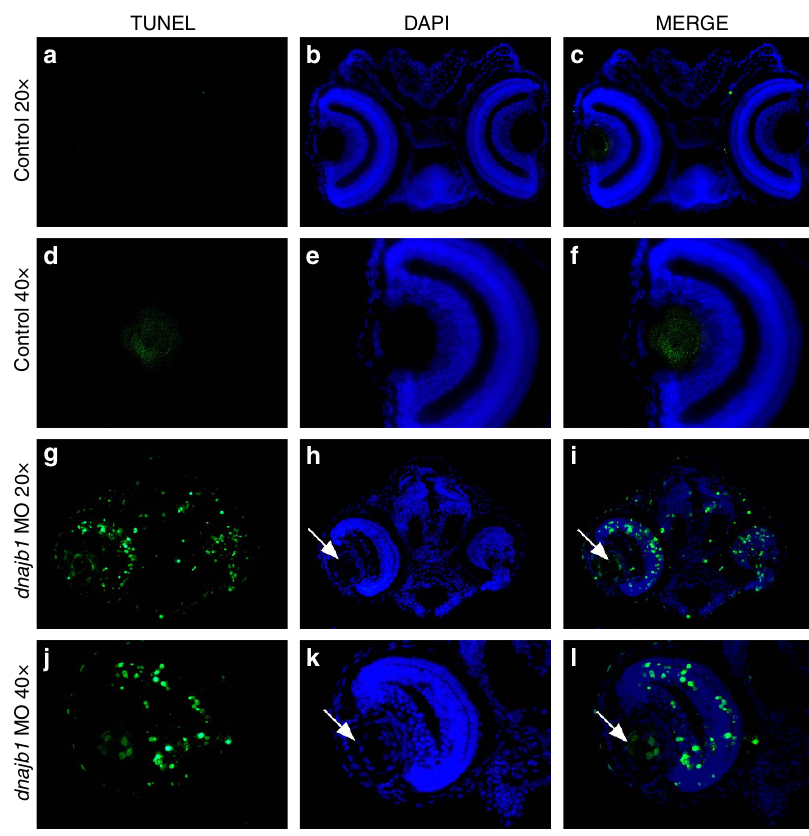
Figure 6 | dnajb1 morphants display significant apoptosis in the eye. TUNEL staining of control embryo sections ( a – f ) and dnajb1 morphants ( g – l ) injected with the dnajb1a sbMO (5ng). The dnajb1a morphants show significantly increased apoptotic nuclei throughout the eye compared with the control embryo, which was completely devoid of TUNEL-positive nuclei. The morphant lens extends out of the retina and is fused to the cornea with an increased number of nuclei as compared with the control (white arrows, h , k ) and is characterized by the presence of apoptotic nuclei in the centre of the lens (white arrows, i , l ), suggesting an abnormal lens development. Note: the control embryo section image was acquired at a higher exposure time compared with the morphant to produce a